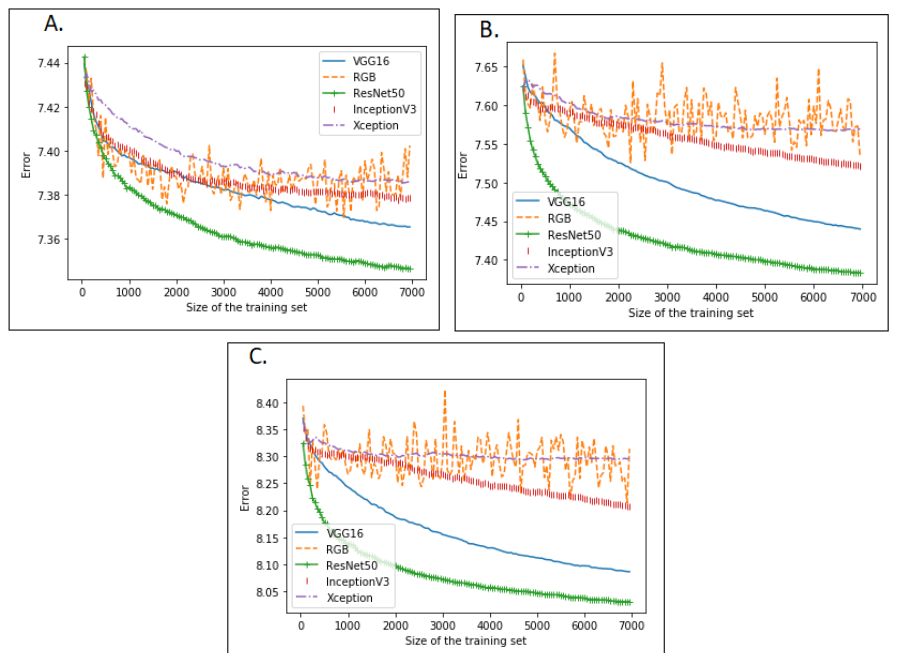
Figure 5. Comparison between RGB pixel-value features, VGG16 features, ResNet50 features, InceptionV3 features and Xception features. ( A ) Text for Sentiment Analysis data set. ( B ) ESP Game data set. ( C ) PadChest data